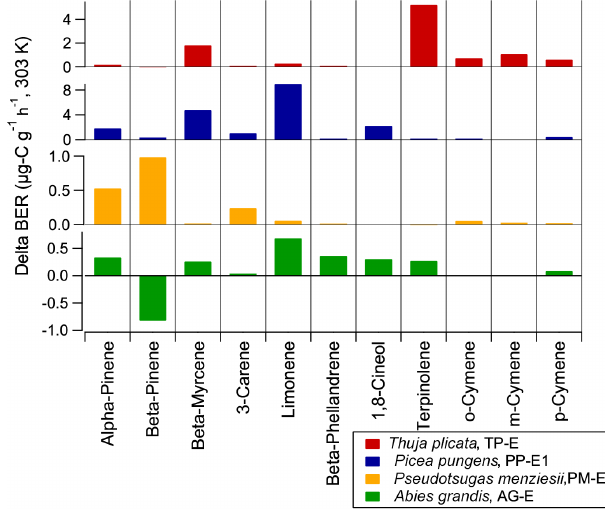
Figure 14. A summary of the change in basal emission rates af- ter stress treatment application for some key compounds for each experiment where a stress response was